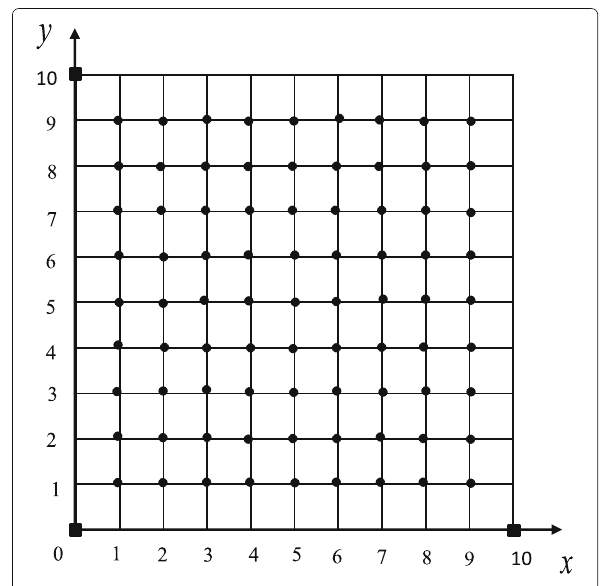
Fig. 2 Grid defining the possible positions